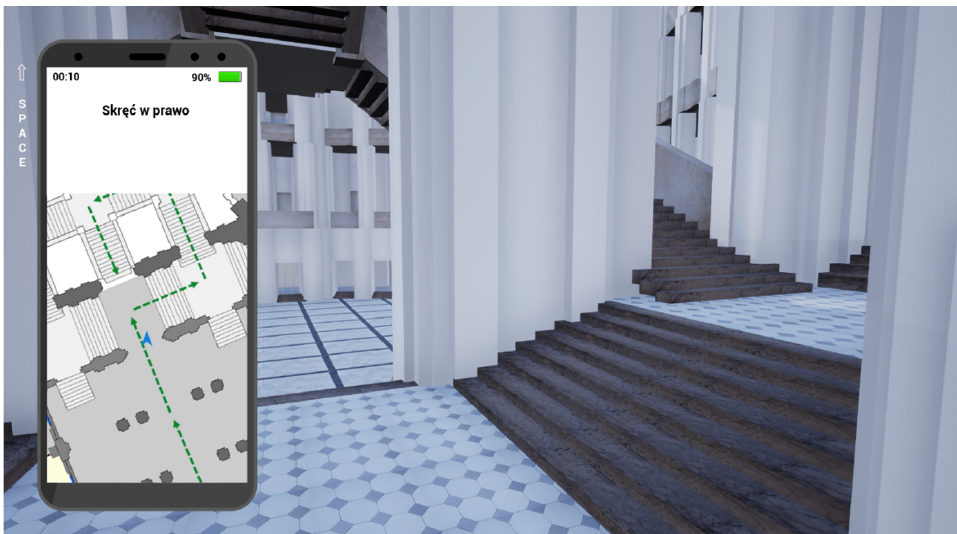
Fig. 9. The map tooltip displayed on user request (the text guidance on this screen is “Turn right”) “look” in the right direction (using proper mouse operation). The frequency and size of the trigger areas varied between the different stages.